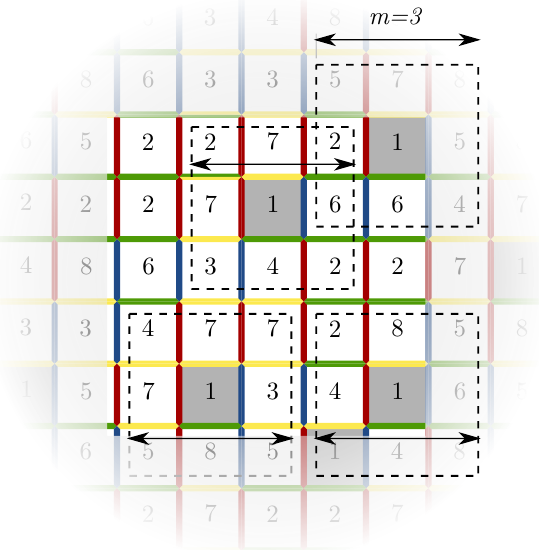
Figure 7. Single layer of surrounding tiles (dashed squares) for different tiles with No. 1.